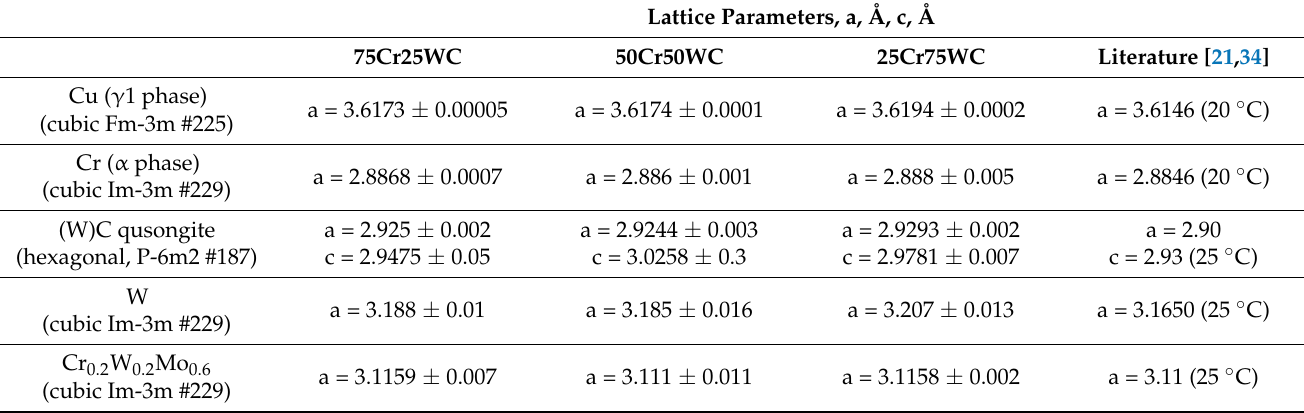
Table 4. Calculated lattice parameters of selected crystalline phases in comparison with the literature values. Lattice Parameters, a, Å, c, Å